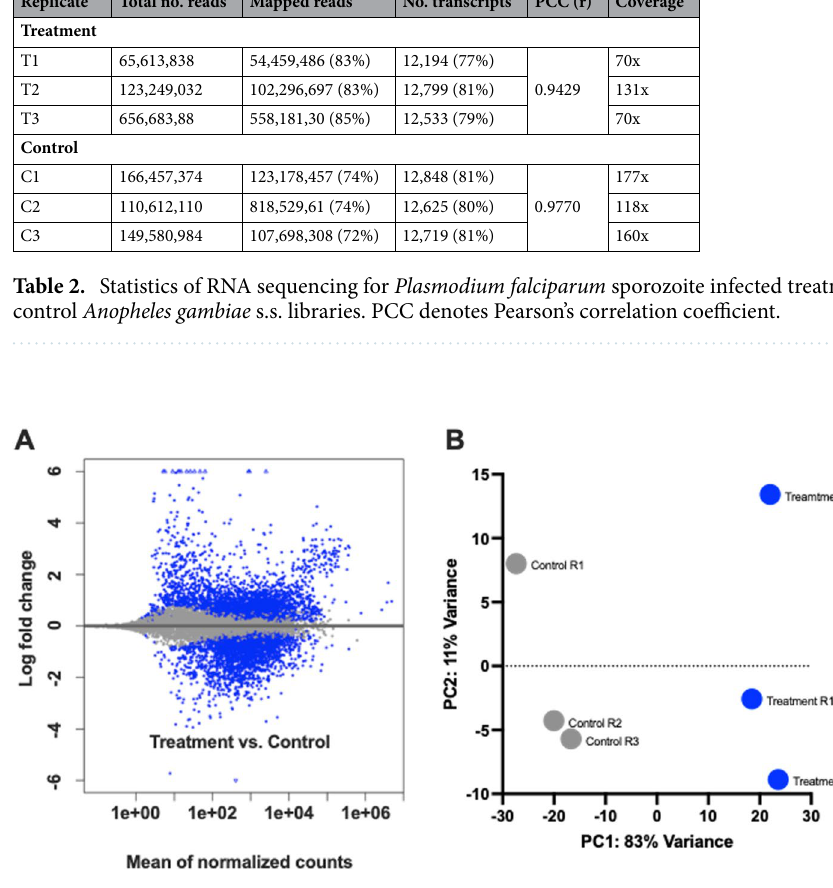
Replicate Total no. reads Mapped reads